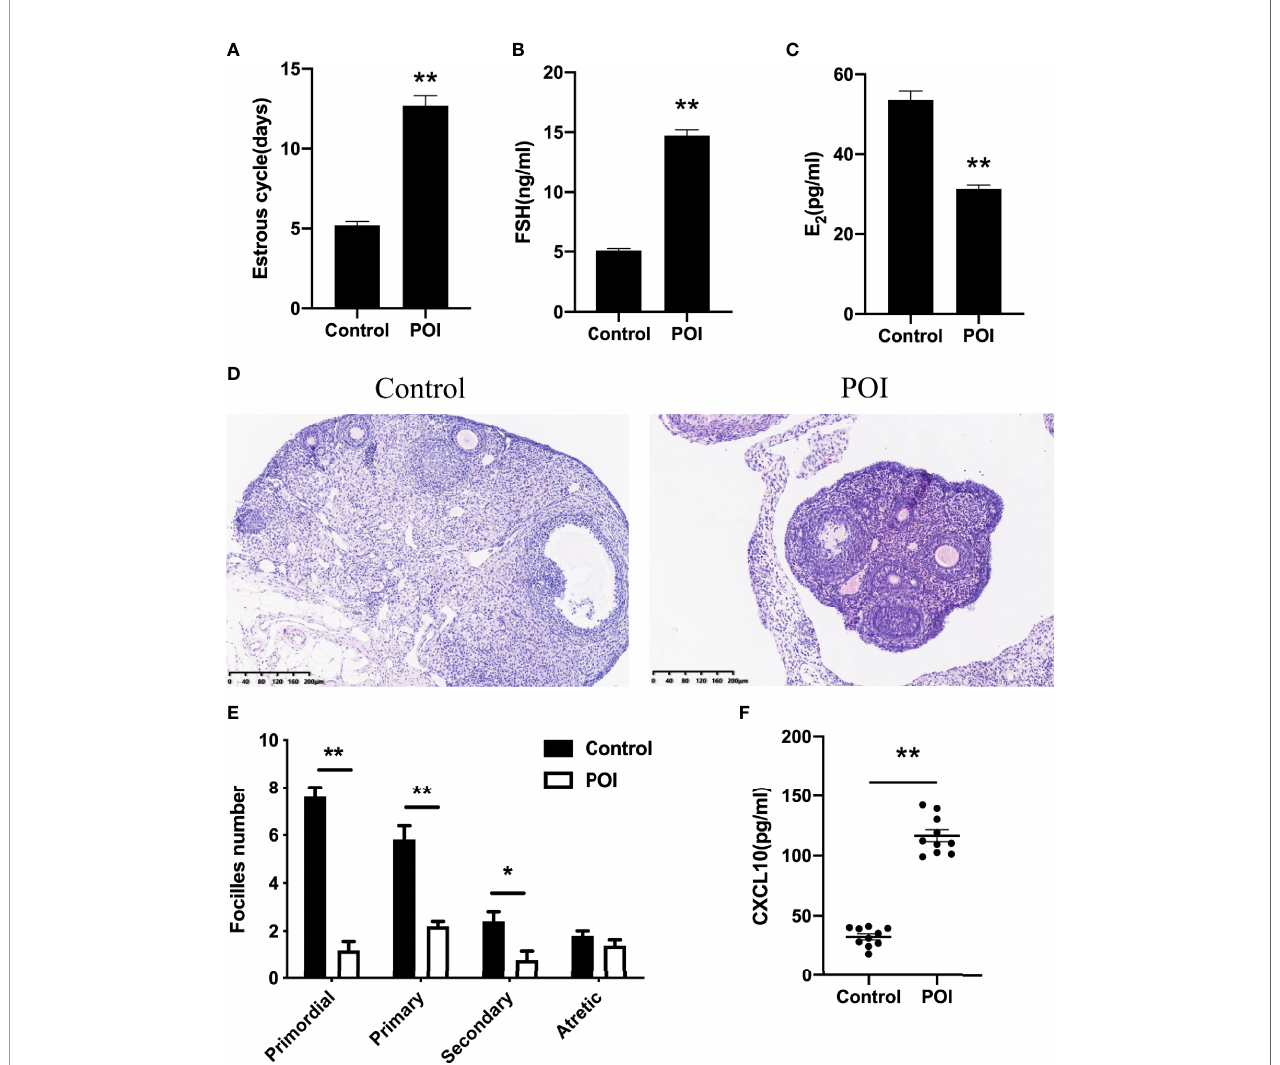
FIGURE 3 | Abundance of CXCL10 in POI mice. (A) Estrous cycles of control mice and POI mice. n = 10. (B) Serum levels of FSH in two groups. n = 10. (C) Serum levels of estradiol in two groups. n = 10. (D) Morphological features by H&E staining in two groups. n = 10. (E) Follicle number changes in the ovaries of two groups. n = 5. (F) Serum CXCL10 levels in control mice and POI mice. n = 10. * P < 0.05, ** P < 0.01 vs.